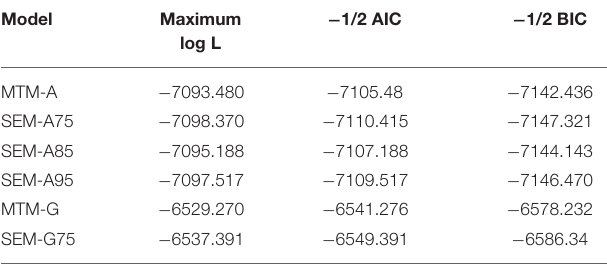
TABLE 1 | Model comparison criteria: logarithm of the restricted maximum likelihood function (log L), Akaike’s information criteria (AIC), Schwarz Bayesian information criteria (BIC) were used evaluate model fit for two multiple trait models (MTM) and four structural equation models (SEM).